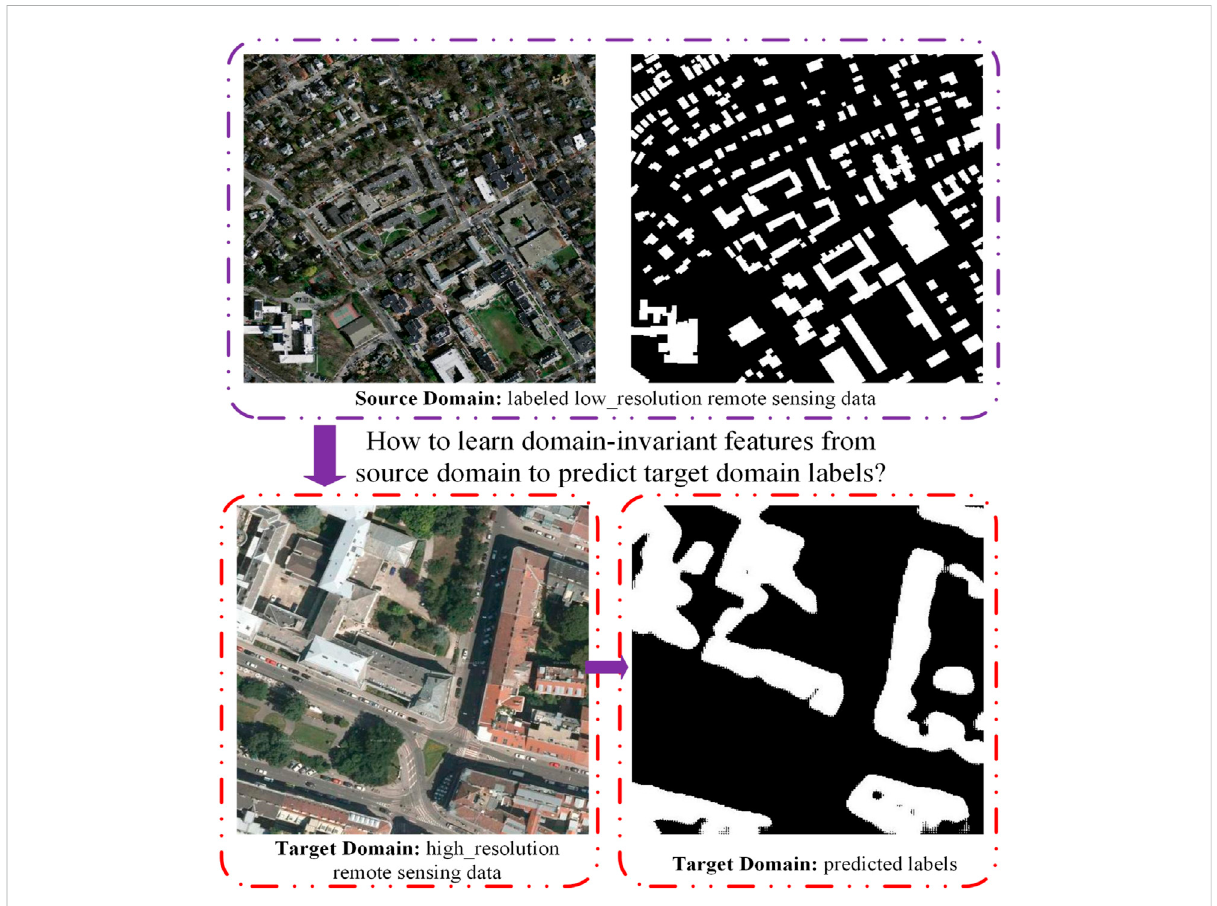
FIGURE 1 Descriptionoftheproblemsetting:givenasourcedomaincomposedoflabeledlow-resolutionremotesensingdata,andatargetdomainmade upofunlabeledhigh-resolutionremotesensingdata,thistaskintendsonpredictingthelabelmapforimagefromthetargetdomainusingasemantic segmentation model trained by source domain